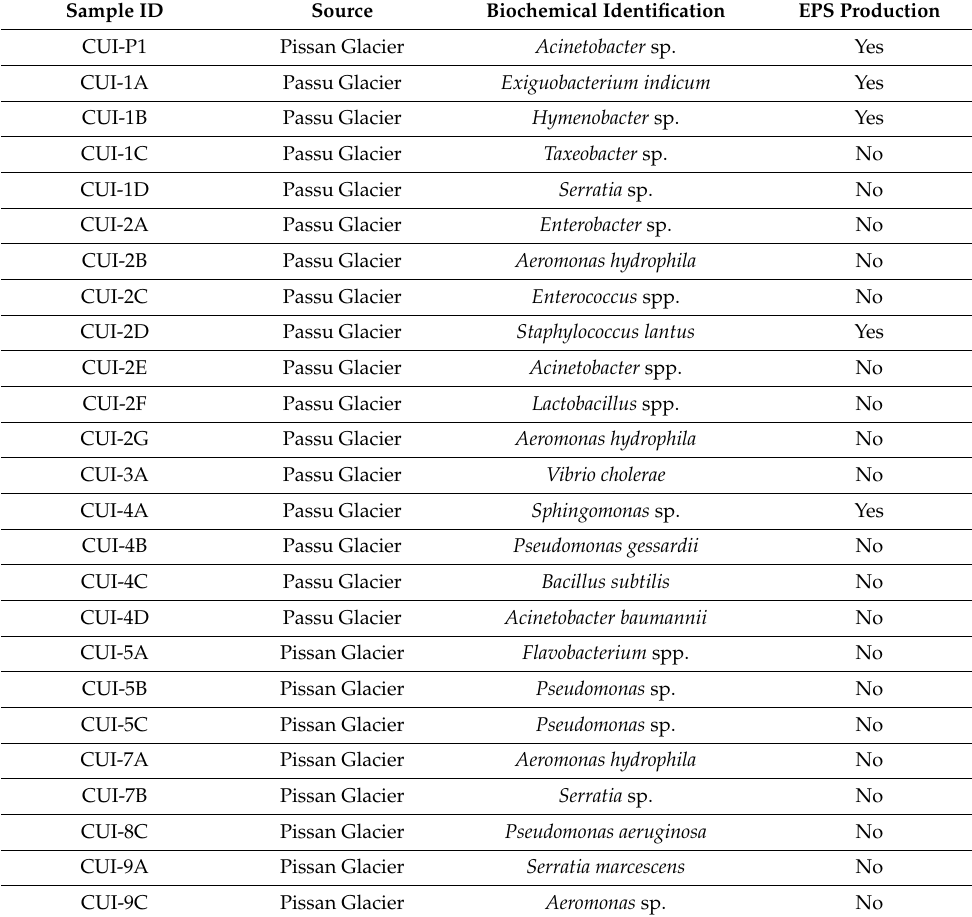
Table 1. Biochemical identification of strains isolated from Passu and Pisan glaciers of Pakistan.